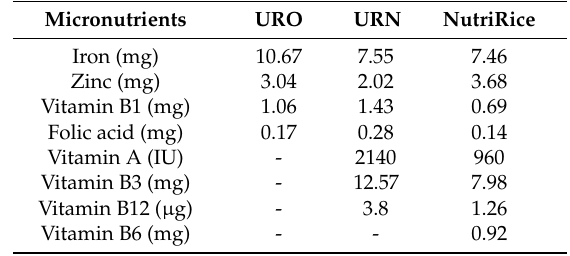
URO: UltraRice original formulation, URN: UltraRice new